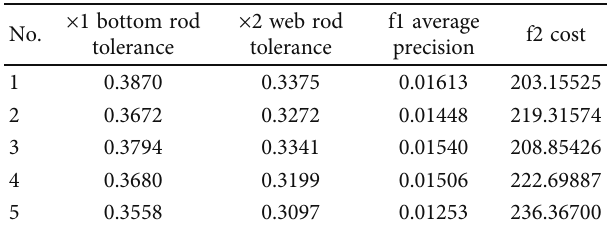
Table 2: Optimization results. × 1 bottom rod No. tolerance